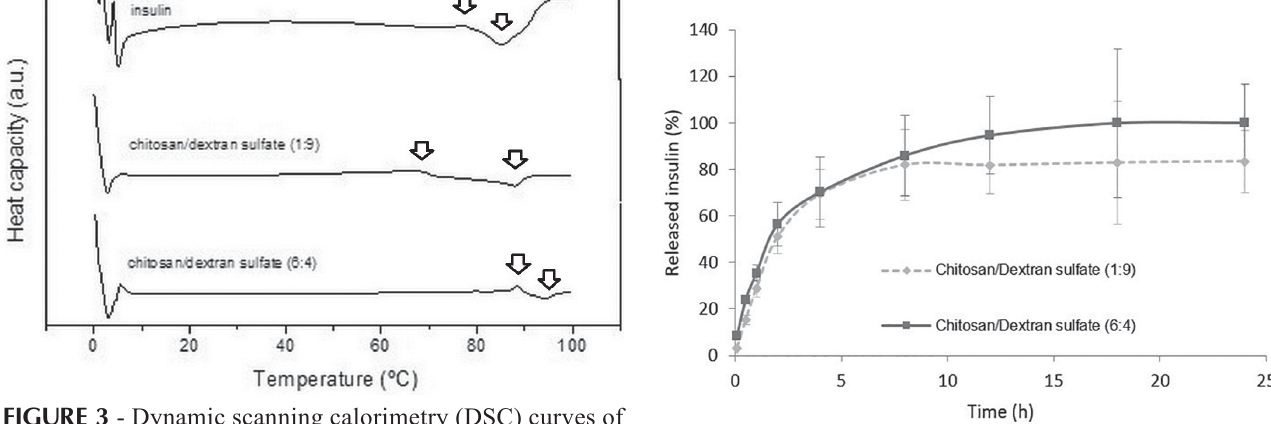
FIGURE 3 - Dynamic scanning calorimetry (DSC) curves of insulin (A), chitosan/dextran sulfate (1:9) nanoparticle (B) and chitosan/dextran sulfate (6:4) nanoparticle (C), heated from 0 to 100